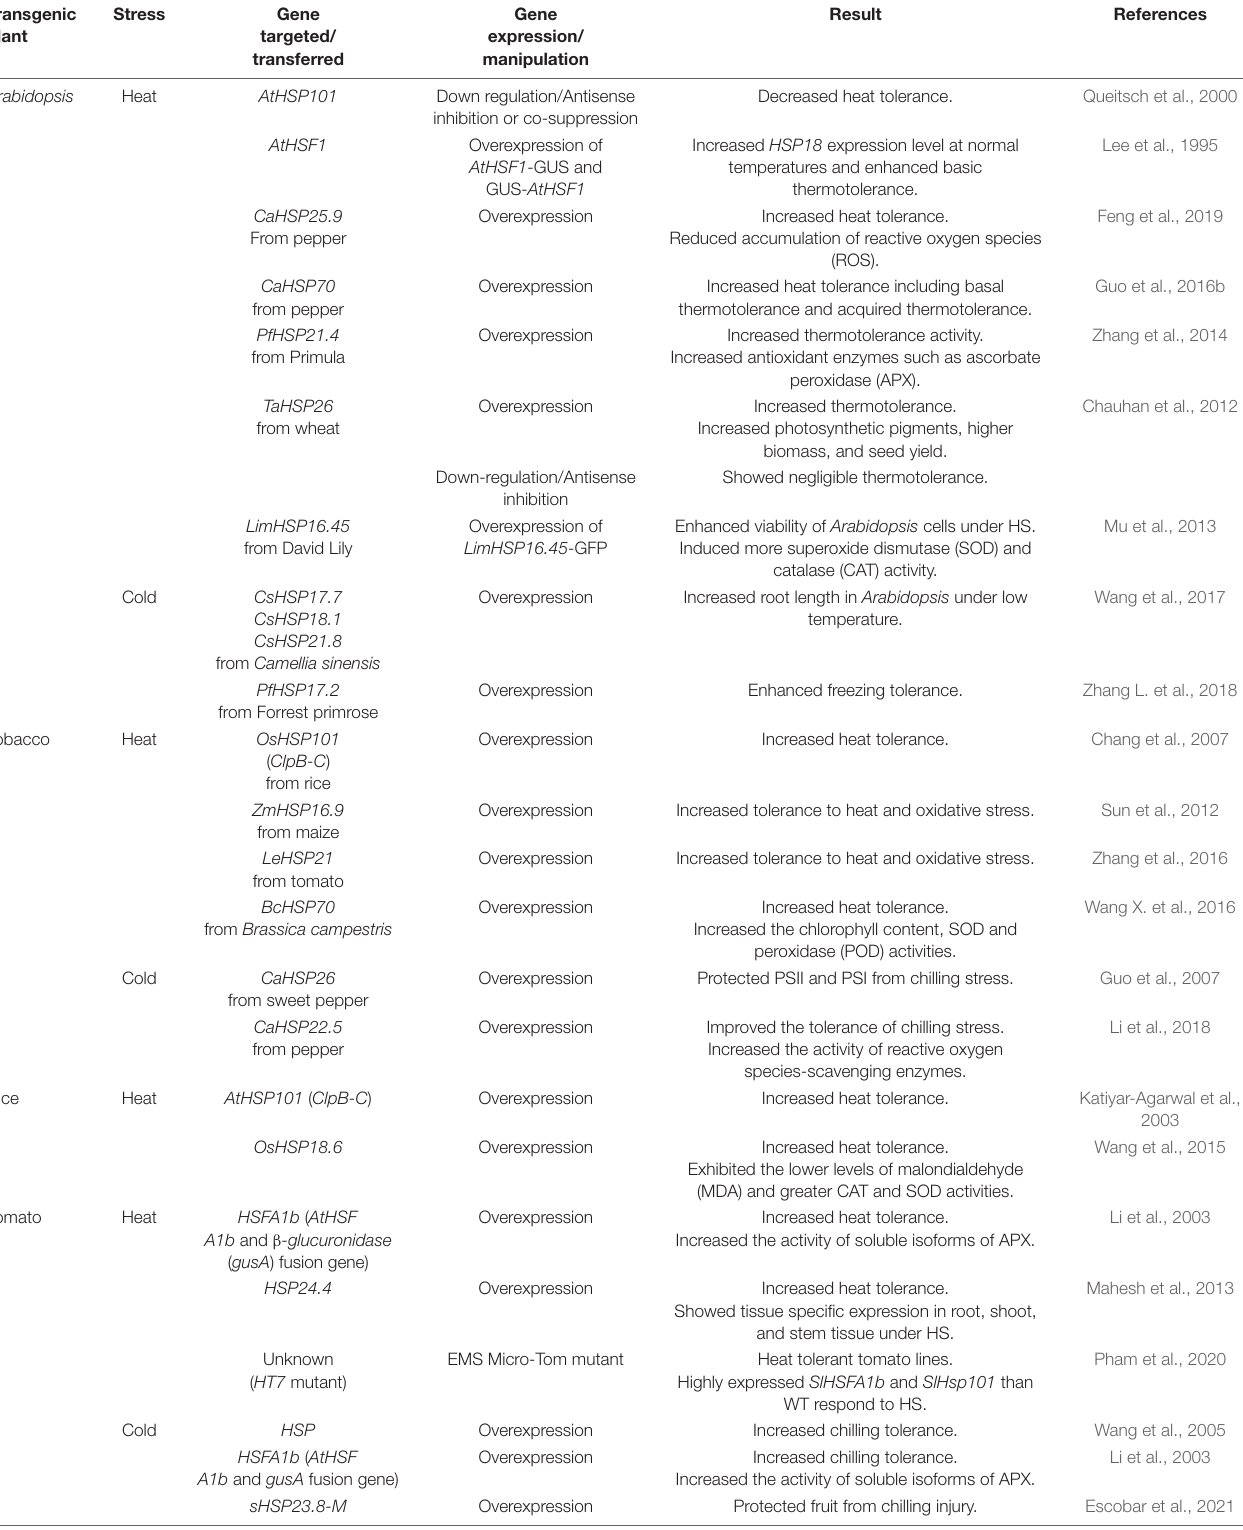
TABLE 3 | Engineering temperature stress tolerance in